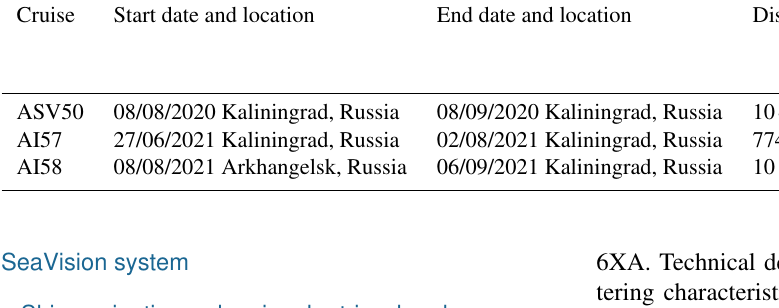
stations (with the Spotter